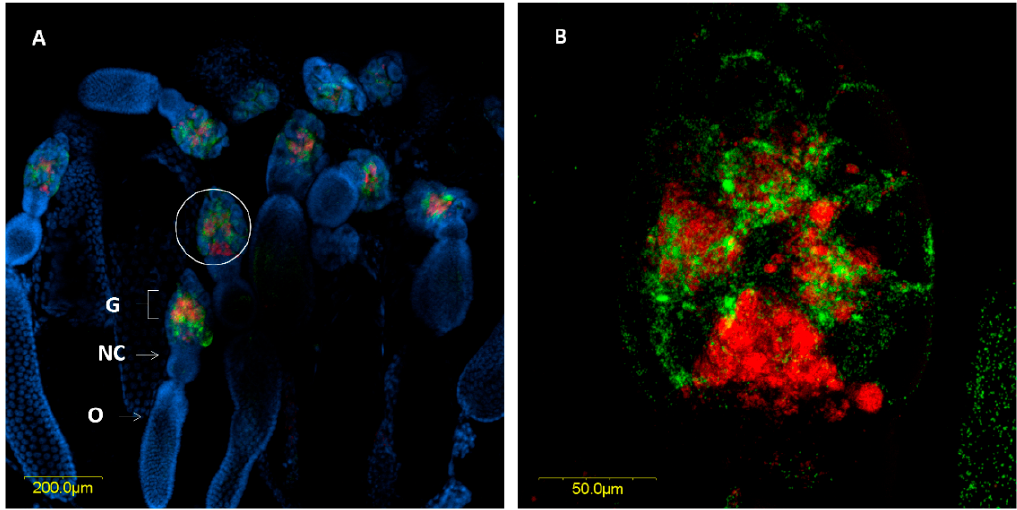
Figure 4. Fluorescence in situ hybridization (FISH) of M. pygmaeus ovarioles, R. bellii specific probes (red), R. limoniae specific probes (green), and DNA dye (blue). ( A ) Ovary with several ovarioles, R. bellii and R. limoniae are concentrated in the germarium; G, Germarium; NC, nurse cells; O, Oocyte. ( B ) Enlarged section of the germarium (white circle in A). Images A and B represent serial Z sections of 35 µm and 13.6 µm, respectively.